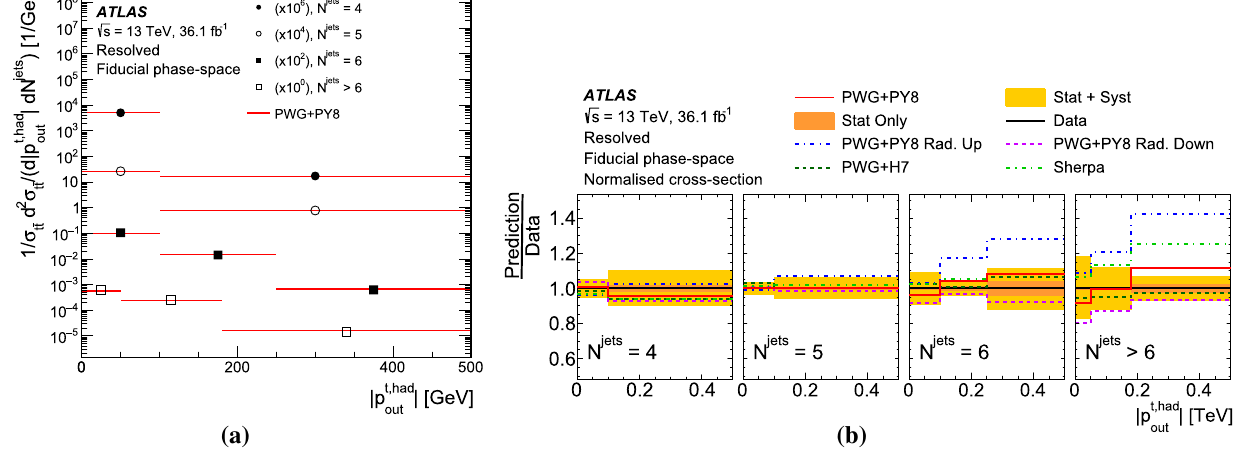
Fig. 33 a Particle-levelnormaliseddifferentialcross-sectionasafunc- (cid:7) (cid:7) (cid:7) (cid:7) (cid:7) in bins of the jet multiplicity in the resolved topology (cid:7) p t , had tion of out compared with the prediction obtained with the Powheg + Pythia8 MC